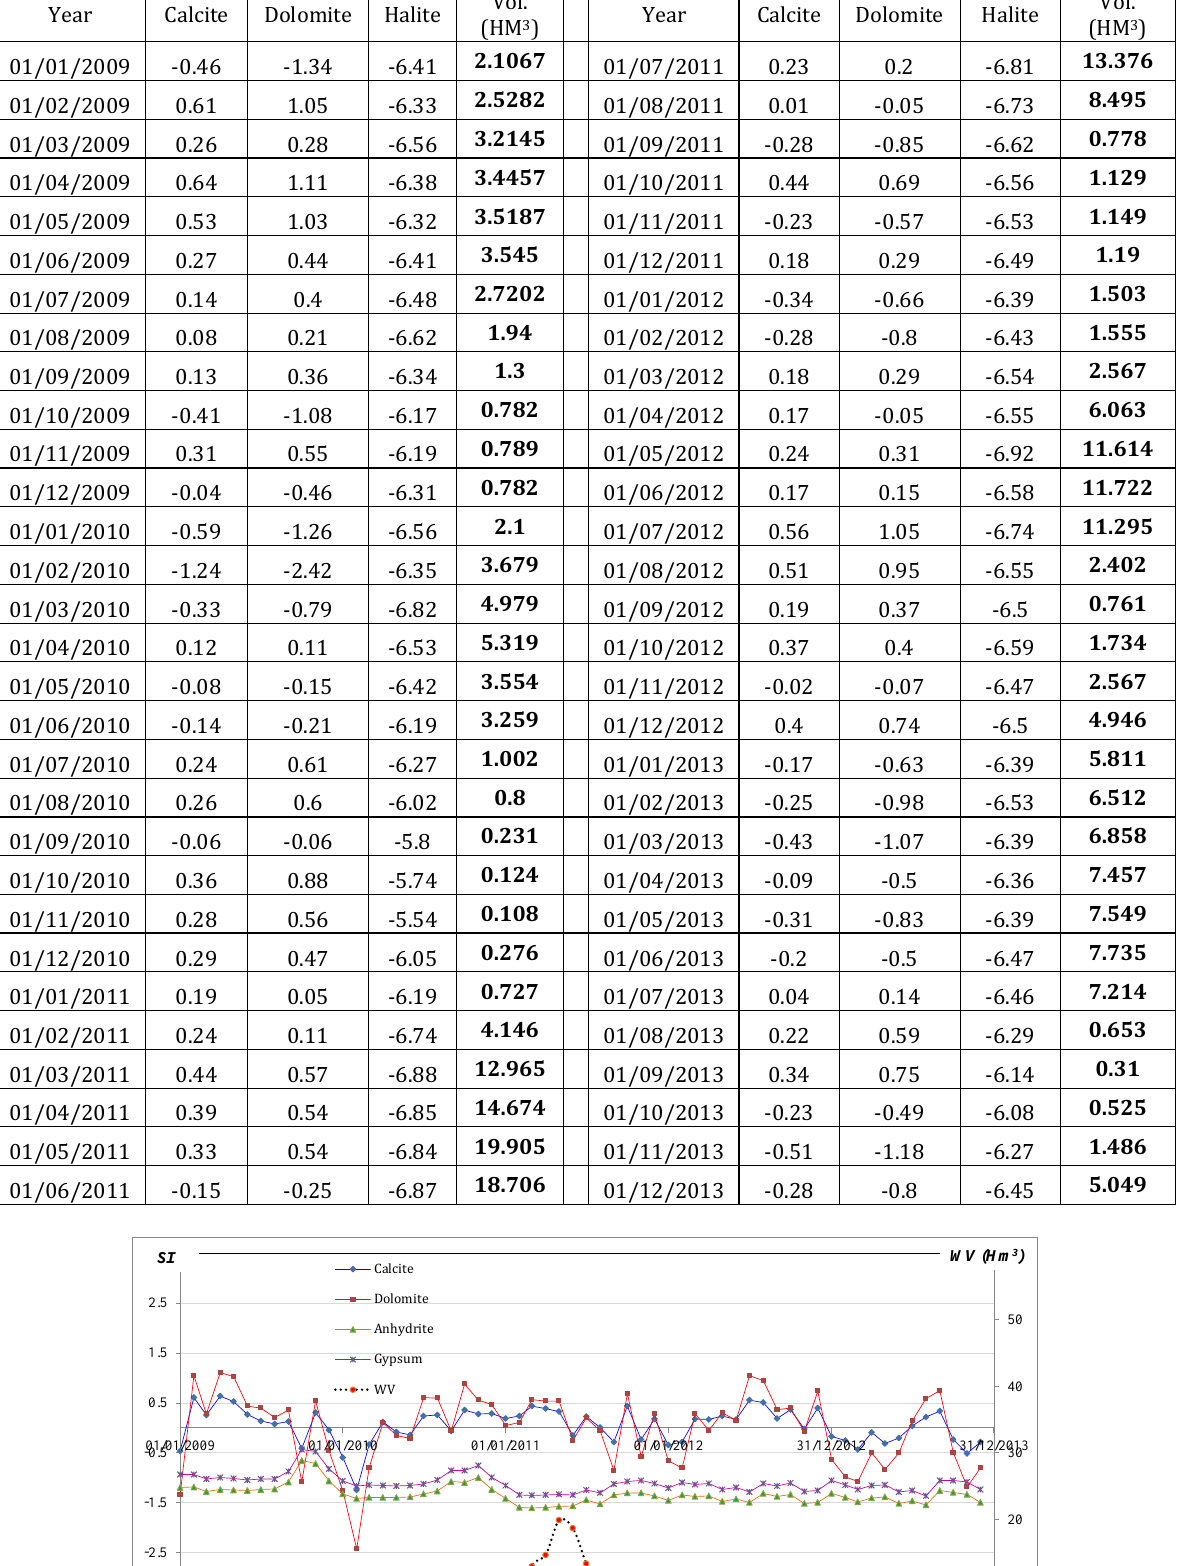
Table 3. Saturation index of calcite, dolomite and halite for the period from 2009 to 2013